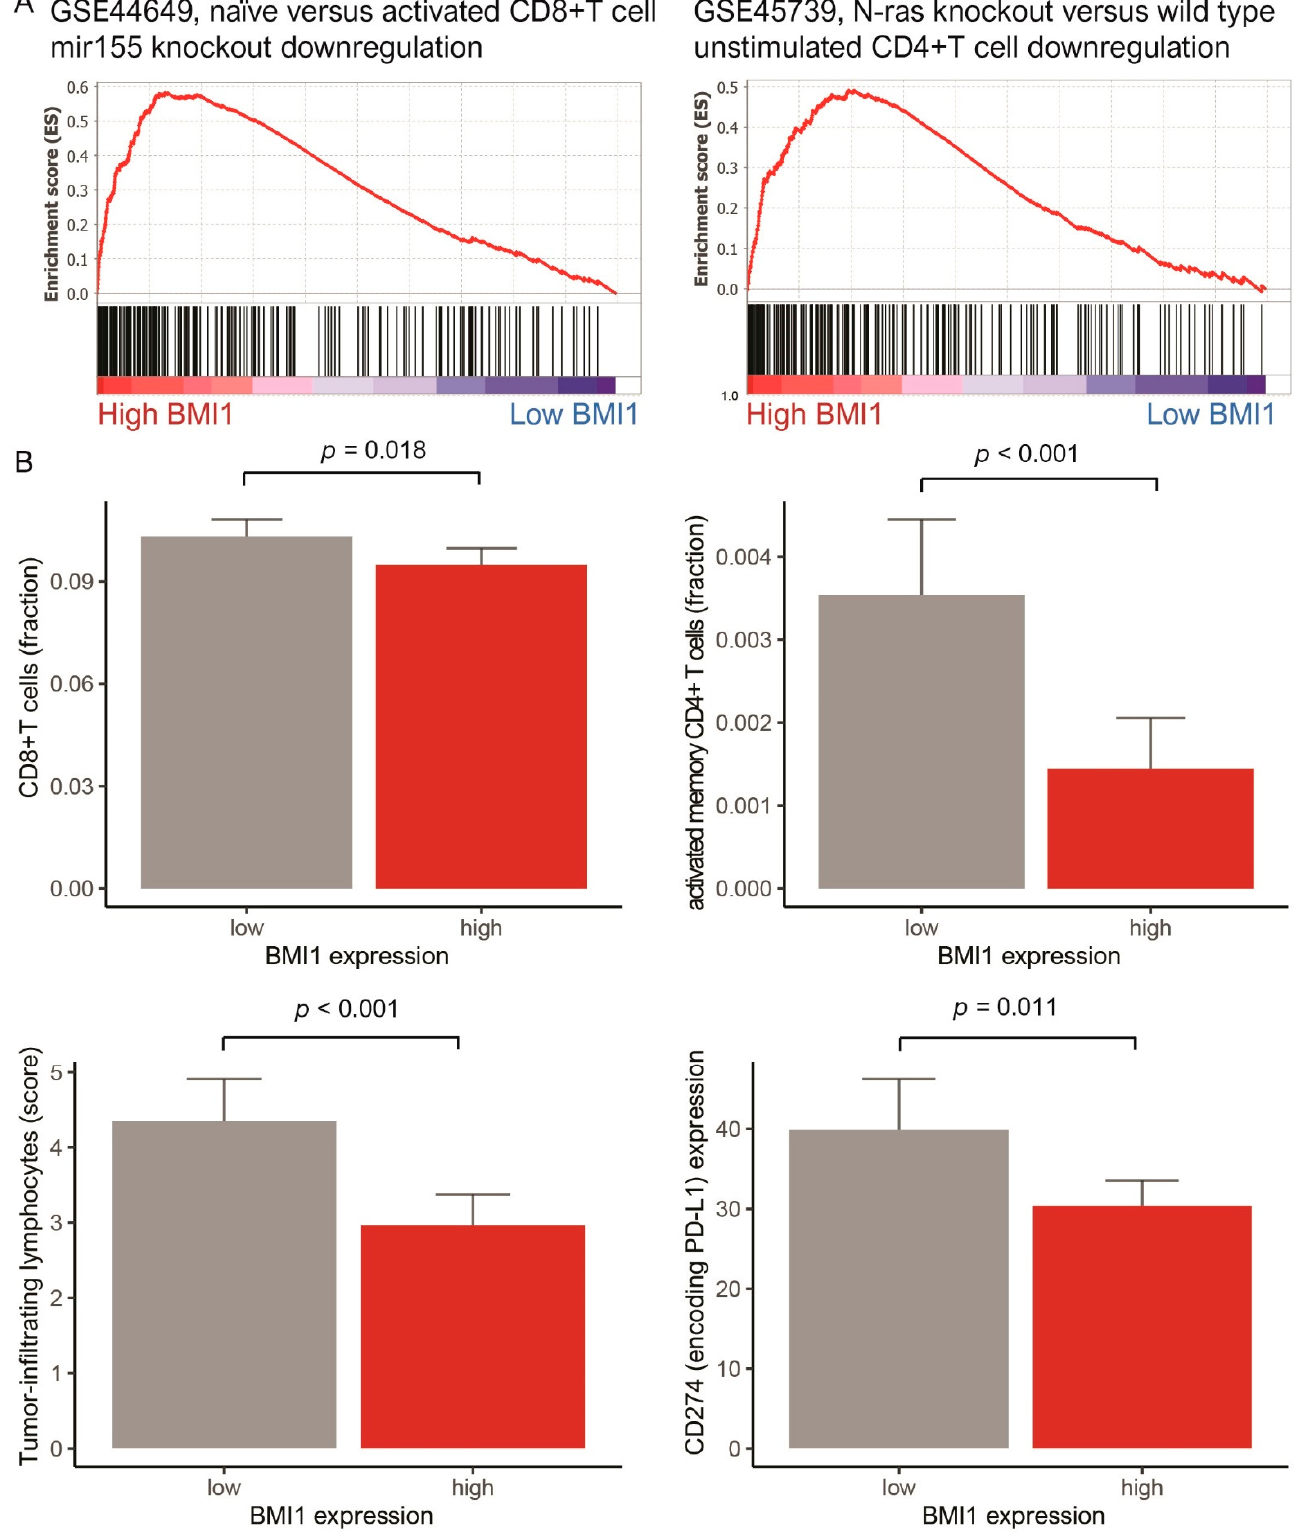
Figure 3. ( A ) Two immunologic gene sets associated with high BMI1 expression: GSE44649, naïve versus activated CD8+ T cell, mir155 knockout downregulation and GSE44649, naïve versus activated CD8+ T cell, unstimulated CD4+ T cell downregulation. ( B ) Bar plots showing the relationship of BMI1 expression with the following parameters: CD8+ T cells, activated memory CD4+ T cells, tumor-infiltrating lymphocytes, and CD274 ( p = 0.018, <0.001, <0.001, and =0.011, respectively) (error bars: standard errors of the